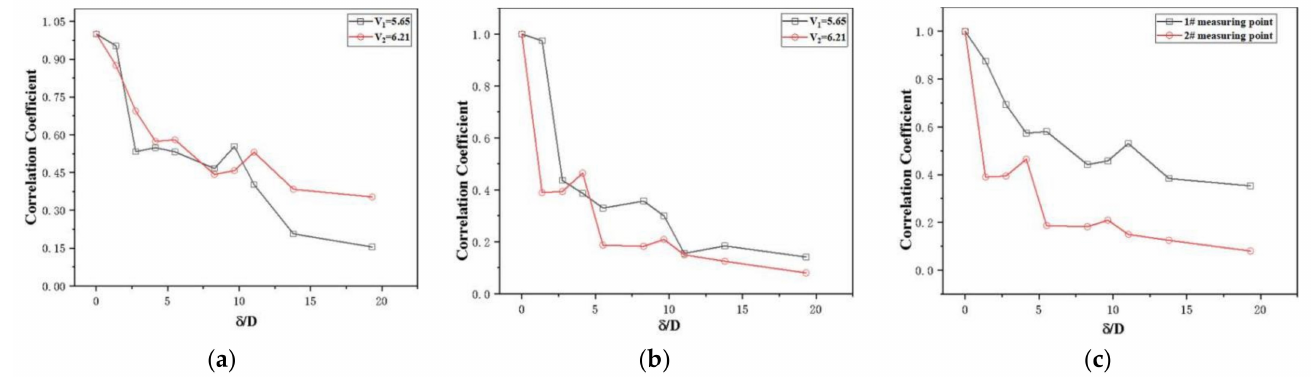
Figure 9. Correlation of pressure coefficient at each measuring point. ( a ) Spanwise correlation of pres- sure coefficient at 1# measuring point; ( b ) Spanwise correlation of pressure coefficient at 2# measuring point; ( c ) Spanwise correlation of pressure coefficient at two measuring points when Vr = 6.21.